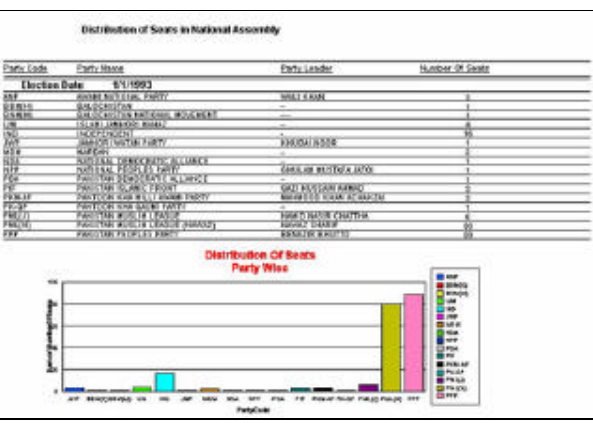
Fig 1: Intelligent Reporting Tool (Selected National Assembly 1993 - 2002 Election Data Party Wise distribution in Last “N”